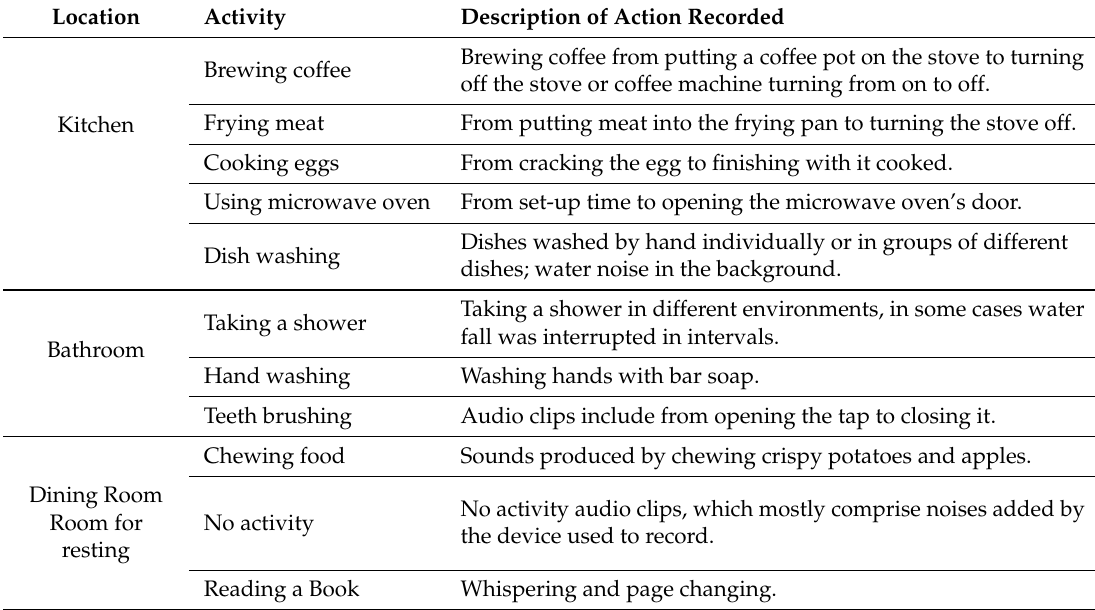
Table 1. Brief description of activities used to describe each of the studied